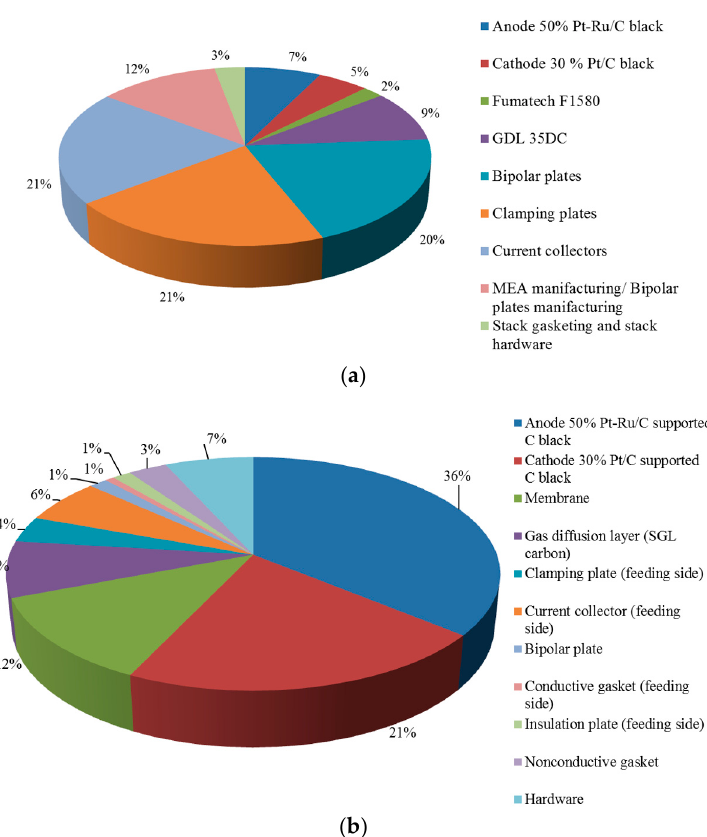
Figure 6. Breakdown of costs percentage for DMFC stack cost components: ( a ) a single stack in small-scale production (200 units per year); and ( b ) a single stack in mass production (10,000 units per year).